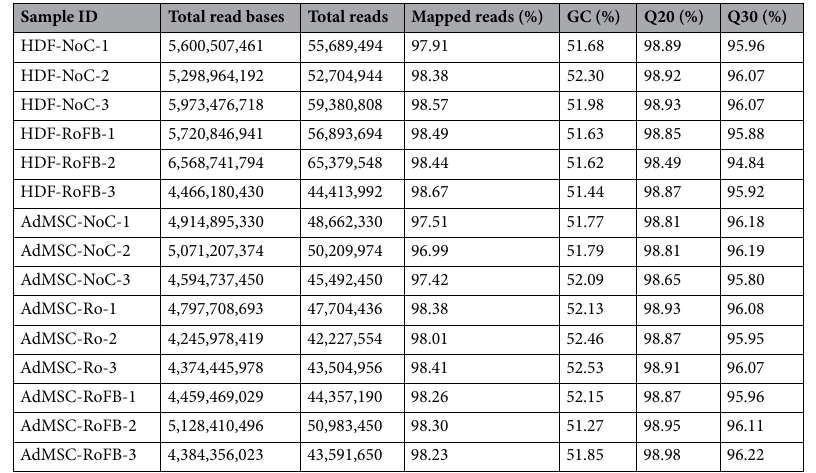
Table 1. Summary of RNA-Seq analysis in ciBAs and AdMSC-derived adipocytes. Total number of bases sequenced, total number of reads, overall read mapping ratio (%), GC content (%), Q20* (%), and Q30** (%) were calculated. *% of bases with quality over Phred score 20. **% of bases with quality over Phred score